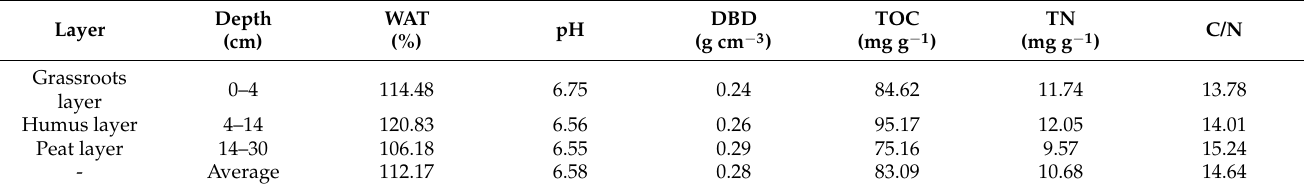
Note: All values were calculated as averages based on every 1-cm soil fraction of the corresponding layers. TOC and TN were based on dry soil mass. For details on TN, TC, and TOC, see Table S4 in the Supplementary